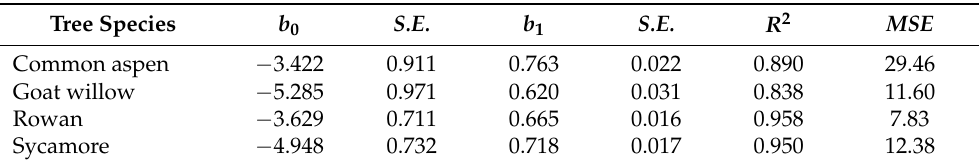
Table 1. Relationships between diameter at breast height DBH and stem base diameter D 0 for four broadleaved tree species explained by the formula: DBH = b 0 + b 1 D 0 where b 0 , b 1 are regres- sion coefficients, S.E . their standard errors, coefficient of determination ( R 2 ), mean squared error ( MSE ). All calculated p -values of derived regression coefficients were <0.001. See Figure 1 for model visualization.